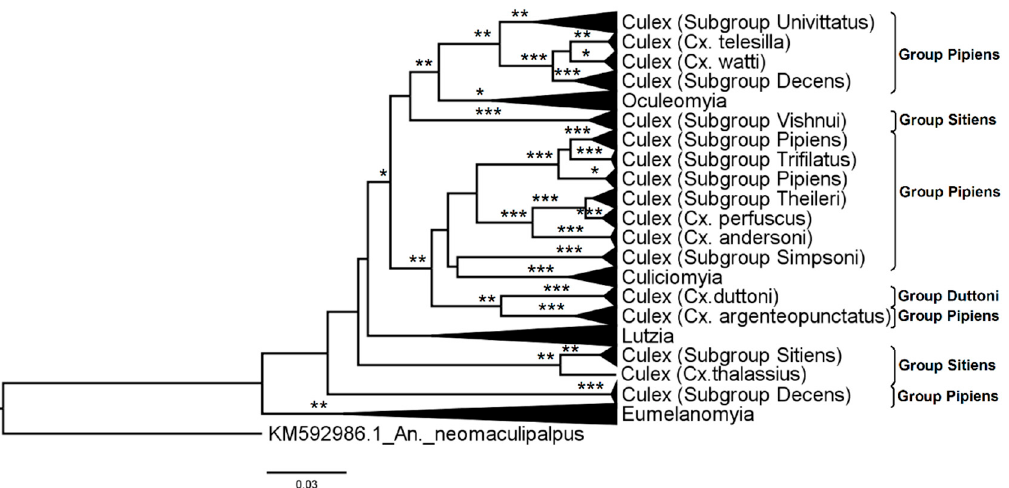
Figure 8. Phylogenetic analysis of 10 partial coxI nucleotide sequences from mosquitoes of the genus Eretmapodites . At specific branches, the number of * indicates the tree topological support revealed by the different phylogenetic reconstruction methods, assuming relevant bootstrap and aLRT values above 75% and posterior probability values above 0.80. The sequences obtained in this work are indicated with the “EM” code and those with associated genitalia are indicated by horizontal blue arrows; the “Grp” indicated group is marked by vertical lines. The sequences downloaded from GenBank and Boldsystems are indicated by their respective accession numbers and access codes (respectively); the symbol “.” after the code of our sequence indicates that said sequence was not identified by Boldsystems. Their country of origin [South Africa (ZA), Ghana (GH), Guinea (GN), Mozambique (MZ), Kenya (KE), Uganda (UG)] are also indicated.